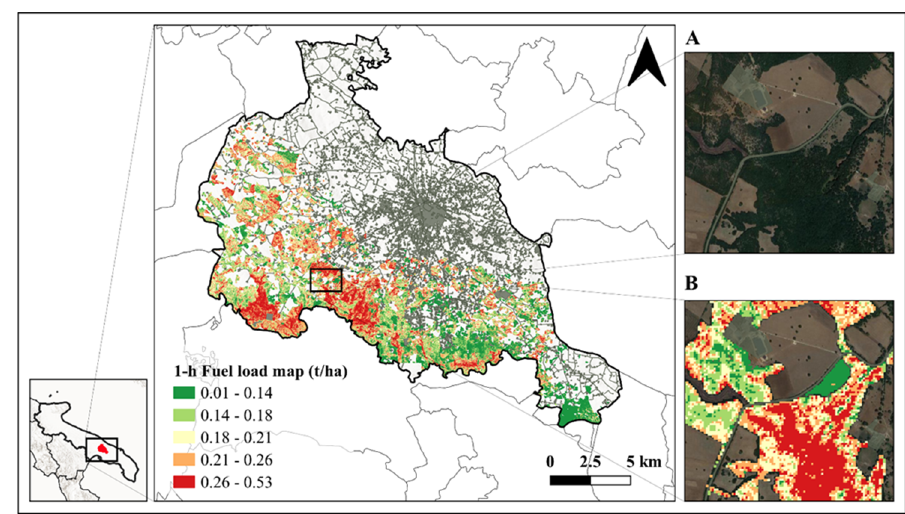
Figure 6. Fine dead fuel map generated by the Random Forest model across a pilot area of the Apulia region (southern Italy). Fuel ranges are expressed in quantiles. A zoomed portion ( left ) of the pilot area without ( A ) and with ( B ) the 1-h fuel load map overlay. The highest 1-h fuel load predicted (0.26–0.53 t/ha) was recorded in the south-west part of the pilot area where deciduous forests can be found. Likewise, the lowest estimated 1-h fuel load (0.01–0.14 t/ha) was found in the south-east portion of the pilot area, mostly covered by meadows and pastures. Table 5 represents the distribution of each land-cover category in terms of surface area (ha) within the 1-h fuel load classes as estimated by the RF model. Table 5. Distribution of land-cover categories in terms of surface area (ha) within the 1-h fuel load classes as estimated by the Random Forest model in the pilot area of Martina Franca. Land-Cover